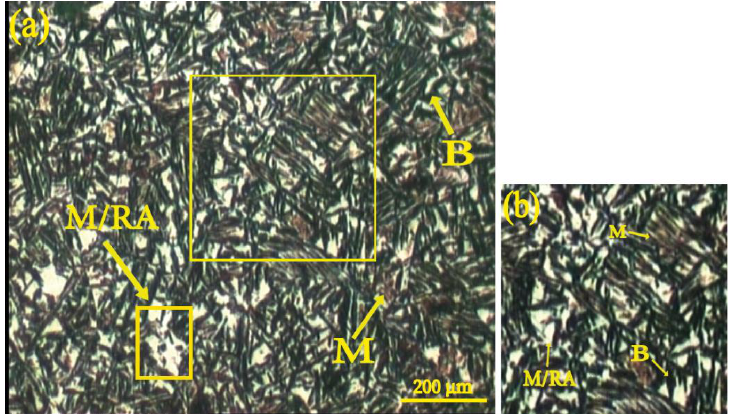
Figure 3. ( a ) Double-step I etching method (10% ammonium persulfate solution + Marble’s reagent). ( b ) Enlarged image view of the square shown in ( a ). The abbreviations B, M and M/RA represent bainite, martensite and martensite/retained austenite phase constituents, respectively.